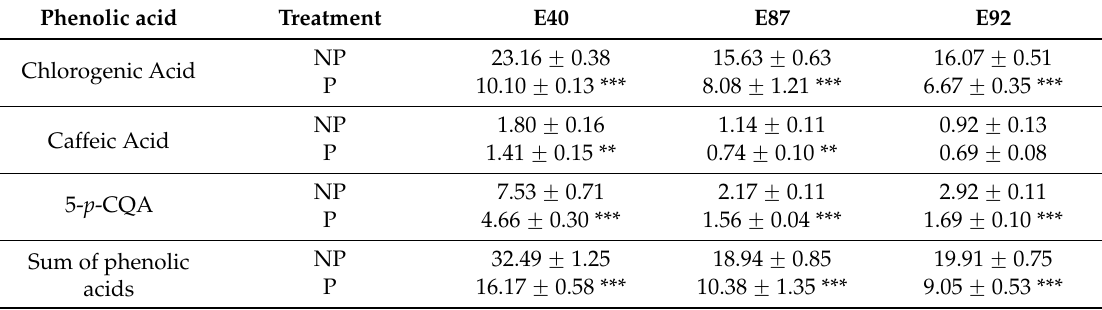
Table 3. Quantification of phenolic acids in yellow tomato lines before (NP) and after (P) processing. Phenolic acid